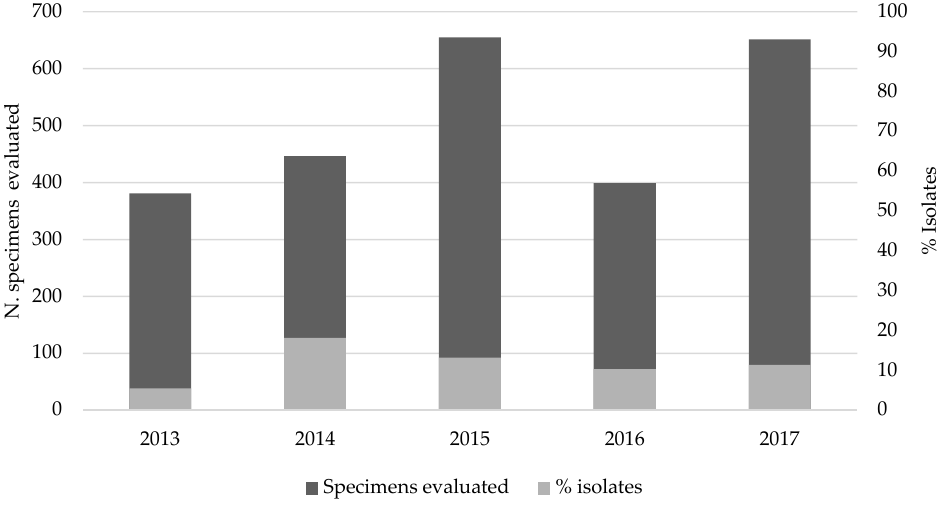
Figure2. Proportionofenterovirusdetectionbasedoncellcultureisolationinasepticmeningitispatients. Figure 2. Proportion of enterovirus detection based on cell culture isolation in aseptic meningitis patients.